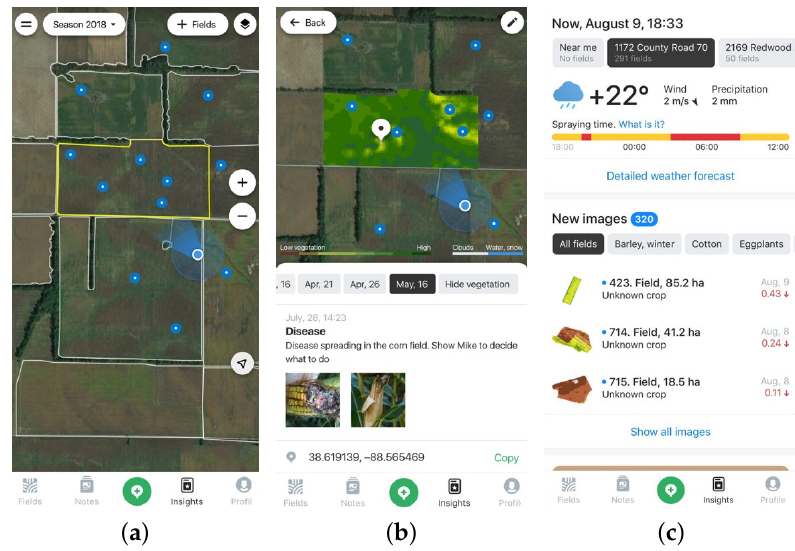
Figure 26. OneSoil Scouting: ( a ) Add and view the fields; ( b ) Create anomaly notes; ( c ) View weather forecasts.